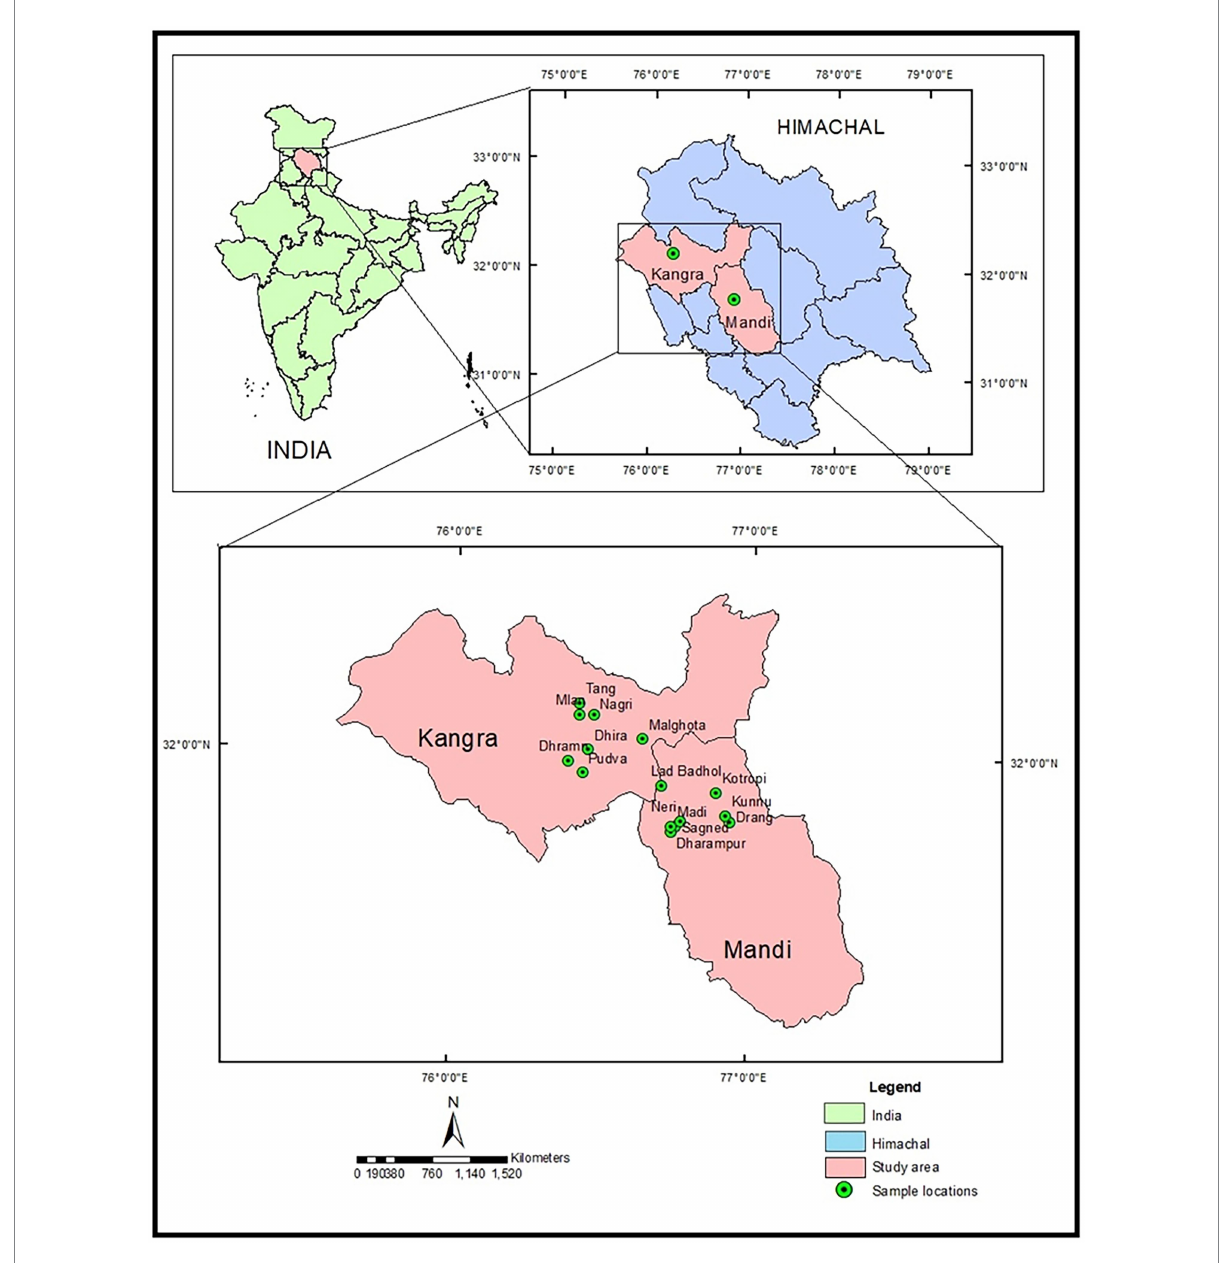
FIGURE 1 Map of Himachal Pradesh showing study area and sample collection